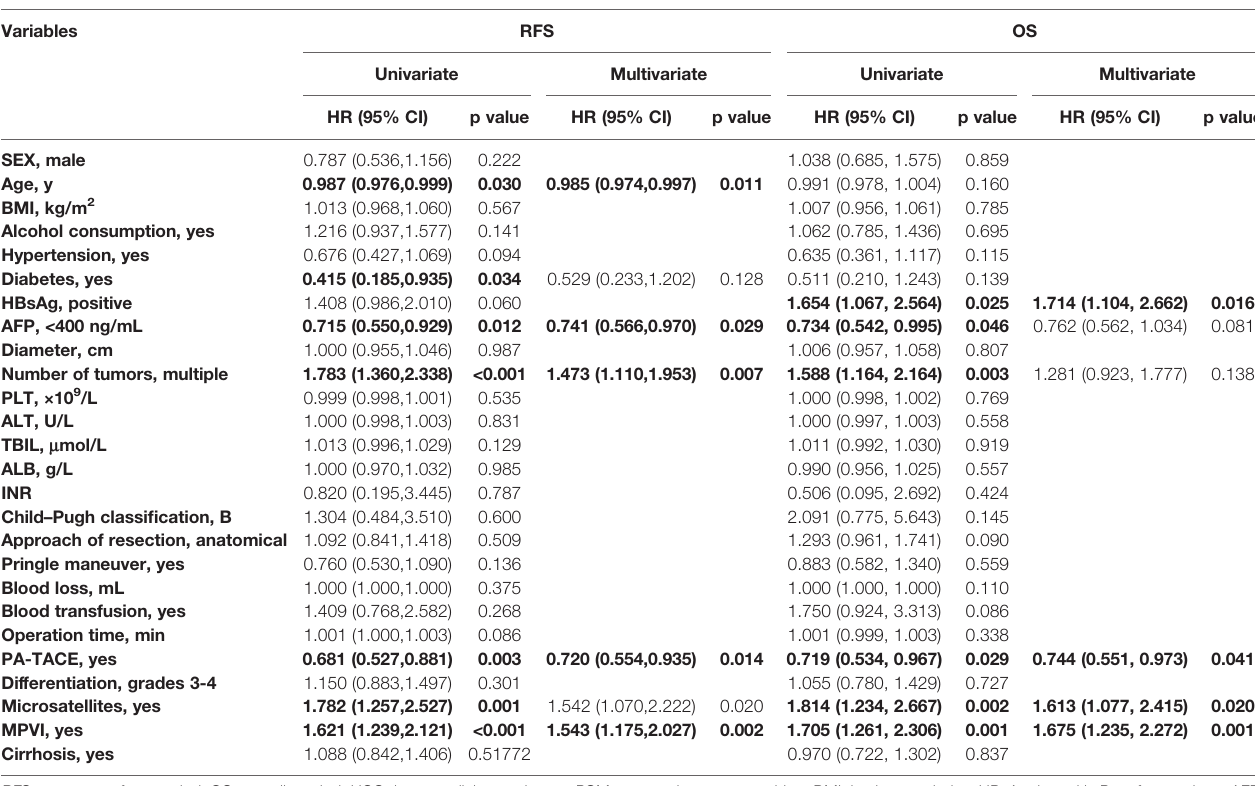
TABLE 3 | Univariate and multivariate analysis for RFS and OS in HCC patients with MVI in the PSM cohort. Variables RFS OS Univariate Multivariate